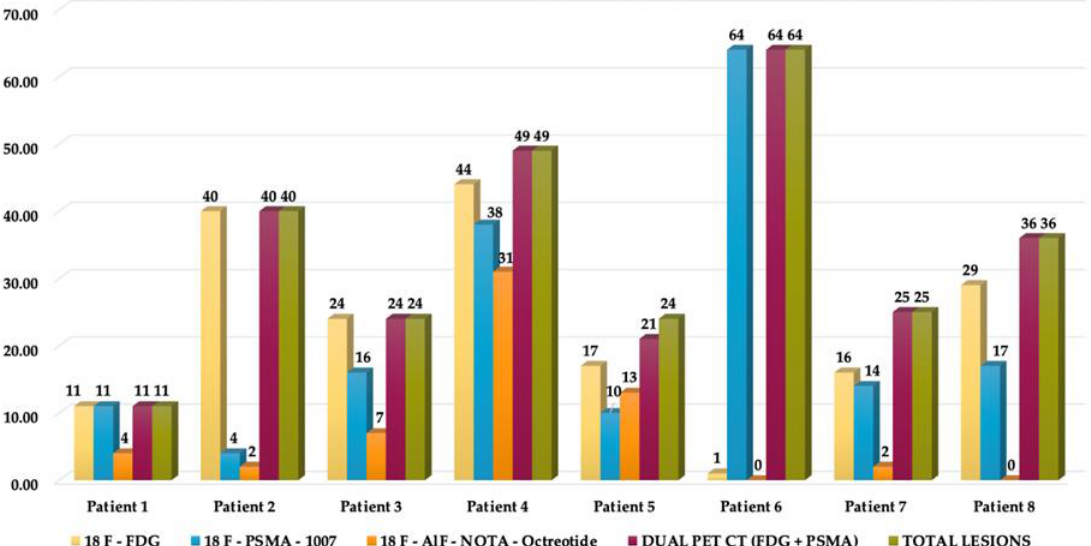
Figure 5. Lesions detection analysis per patient. Total lesions detected by CT were 273 (100%). Total lesions detected by dual PET/CT ( 18 F-FDG + 18 F-PSMA-1007) were 270 (98.9%).